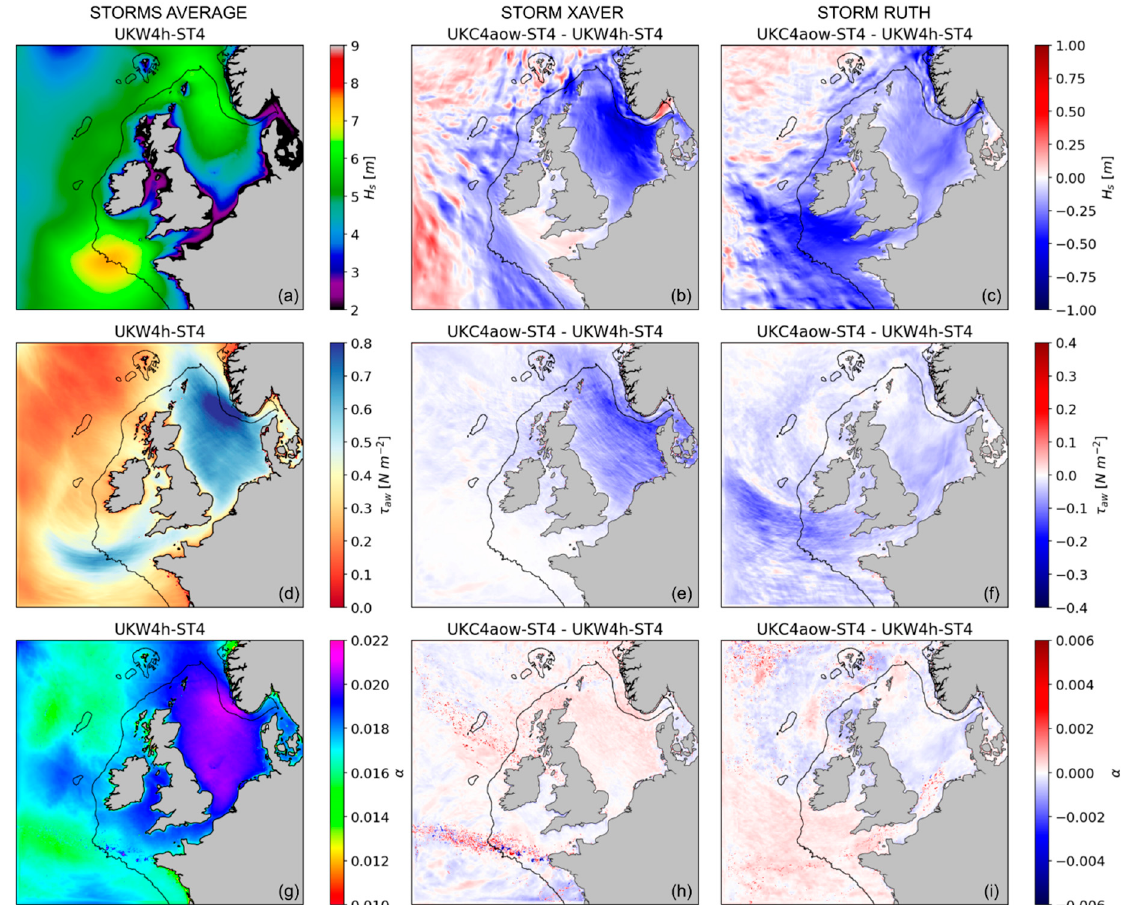
Figure 8. Distribution of mean ( a ) significant wave height ( H s ), ( d ) wave supported wind stress ( τ aw ) and ( g ) Charnock coefficient ( α ) encompassing storms Xaver and Ruth. Difference in ( b , c ) H s , ( e , f ) τ aw and ( h , i ) α between UKC4aow-ST4 and the control model run (UKW4h-ST4) for the individual storms: Xaver (mid panels) and Ruth (right panels). Mean values are computed using the two storms whereas mean differences correspond to each storm individually. The 200-m isobath (solid black contour) is included to indicate the continental shelf limit.